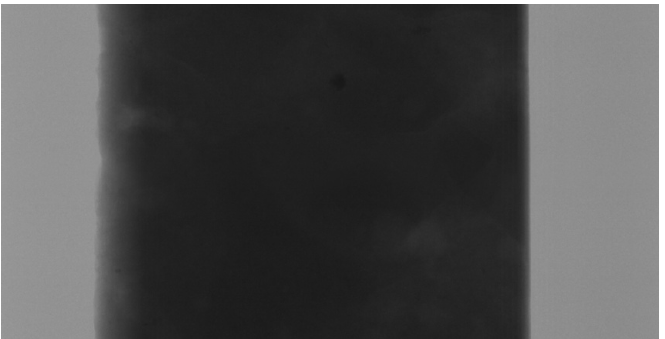
Figure 28. Exemplary projection of material structure.